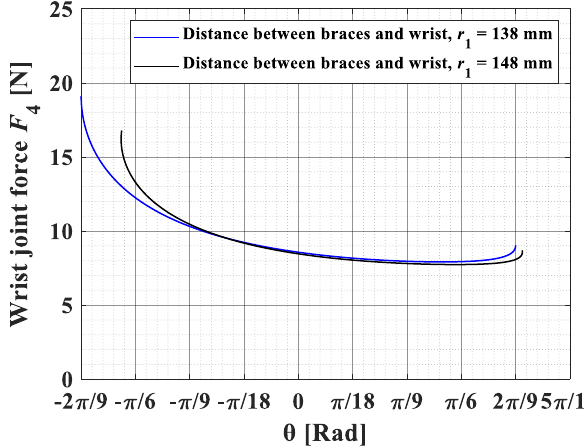
Figure 17. Wrist force comparisons with different distances between braces and wrist.